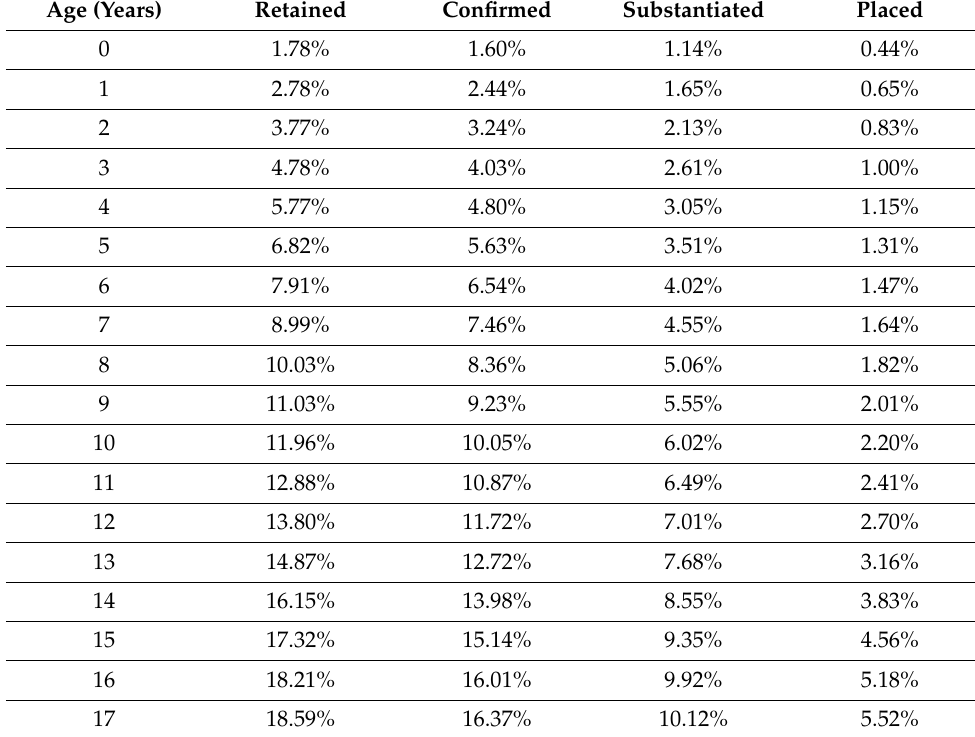
Table 1. Estimated cumulative risk of involvement in child protection in Quebec between 2000 and 2017 (age 0–17